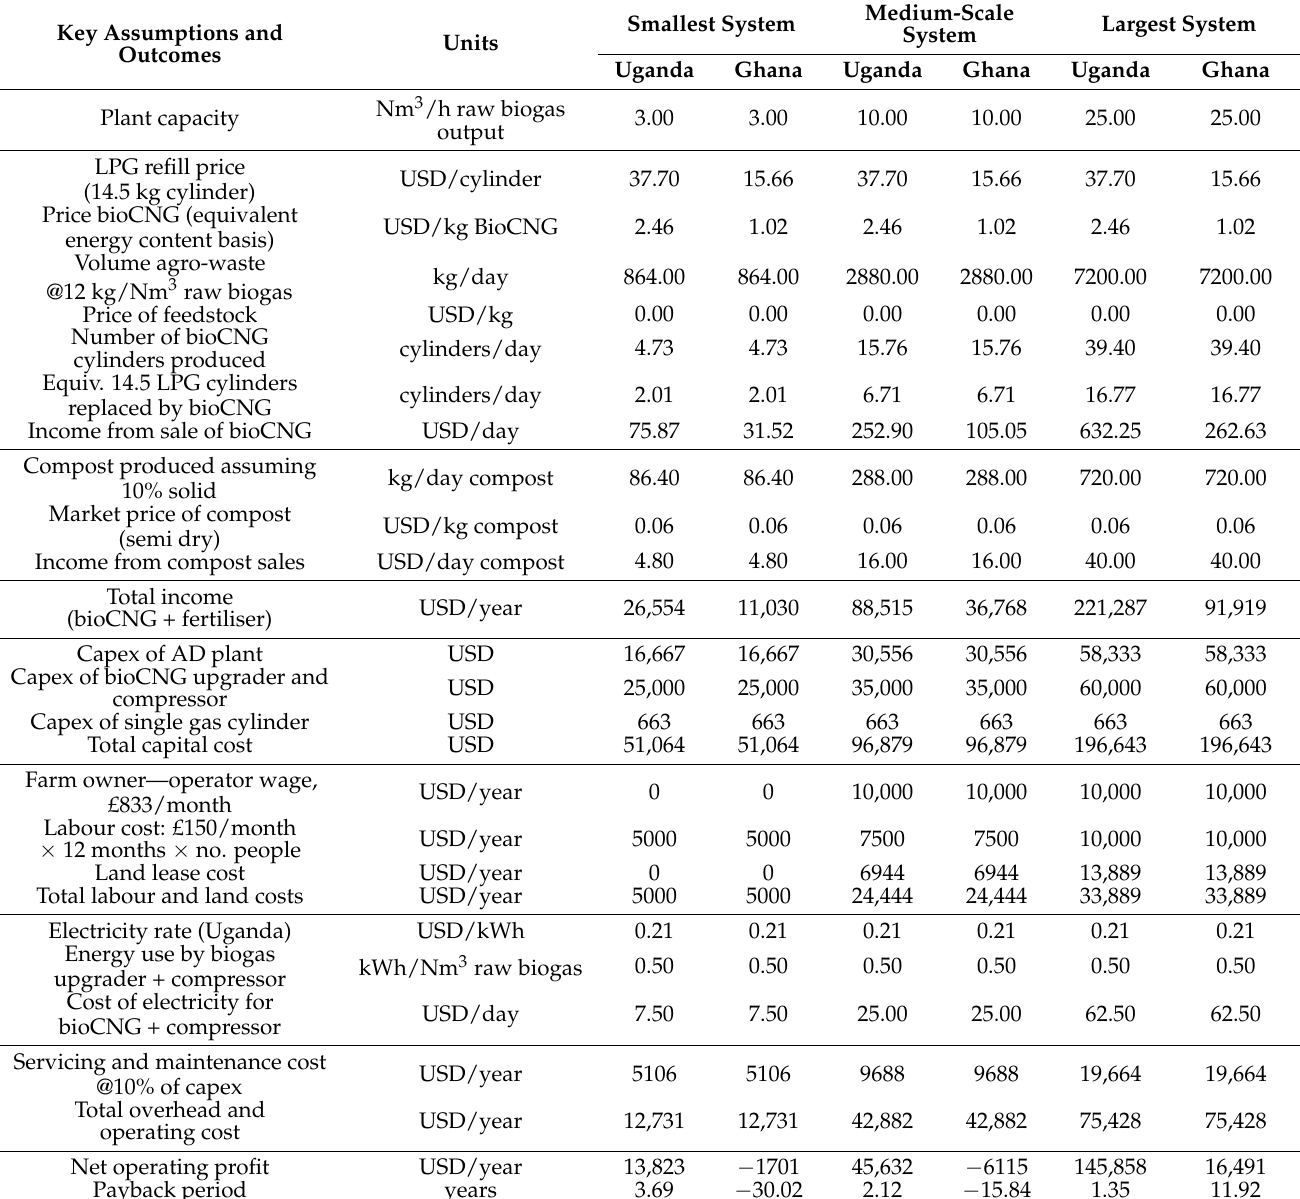
Table 4. Summary techno-economic analysis for bioCNG in Ghana and